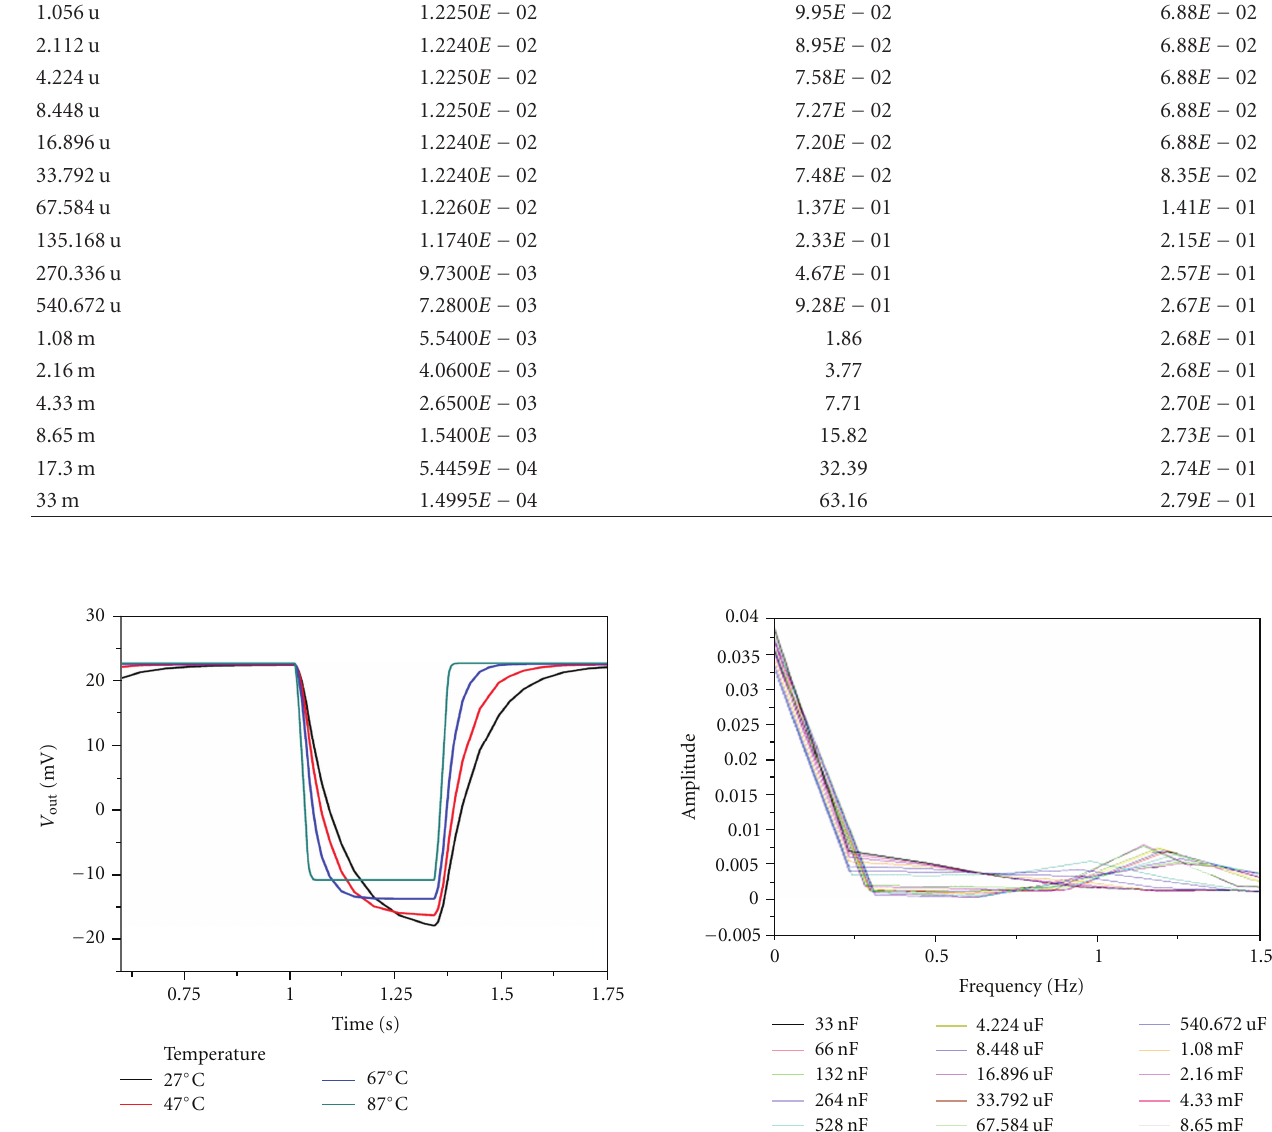
Figure 27: Output data for the pulse parameter for a change of the temperature of C 2 (27 ( ◦ C) ∼ 87 ( ◦ C)).